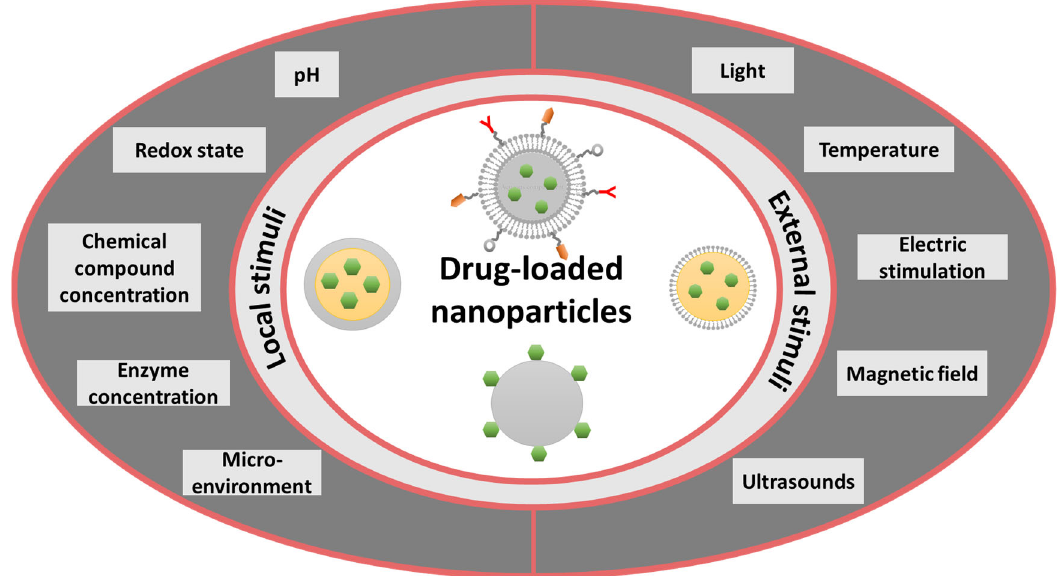
Figure 1. The main types of stimuli-responsive nanoparticles (NPs) for drug delivery.